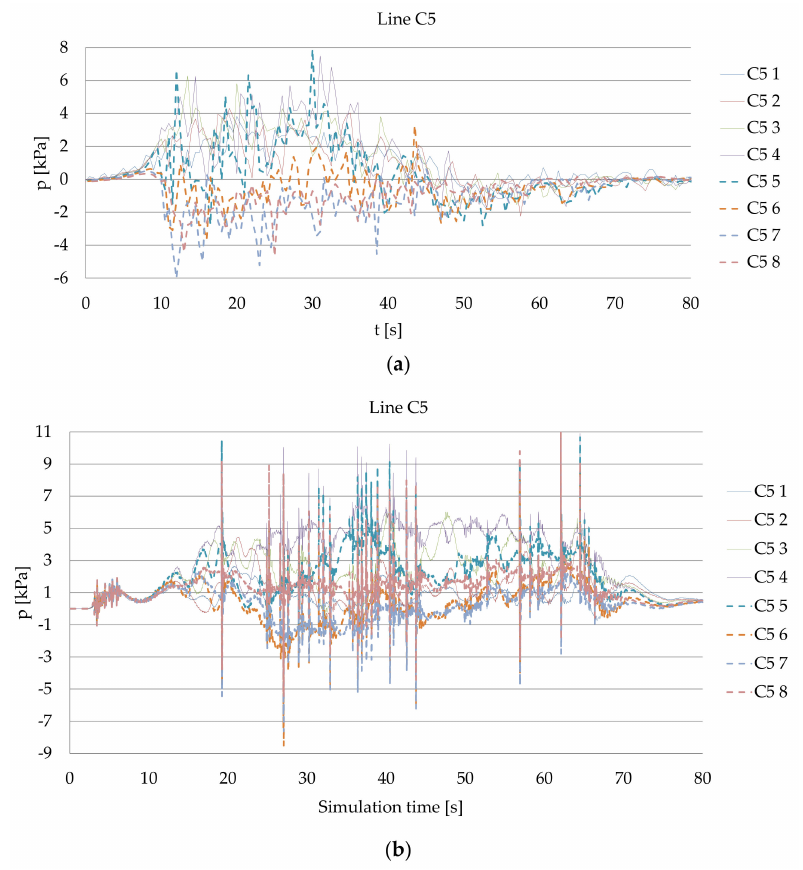
Figure 6. Pressure within the C5 line during the unberthing: ( a ) real measurements for Ferry 1; ( b ) CFD simulation for Ferry 2, both the bow thrusters operating with 130 kN thrust each during the period of time of 60